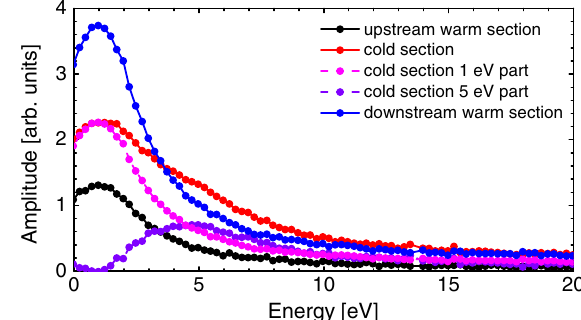
FIG. 11. Energy spectra of negatively charged particles (electrons) between 0 and 20 eV (energy resolution: 0.25 eV), hitting the chamber walls in each of the three sections of COLDDIAG with 250 mA and 900 bunches. The shape of the spectra is independent on the beam current. The energy spectrum in the cold section is split into a peak at 1 eV, proportional to the peaks in the warm sections, and the remaining